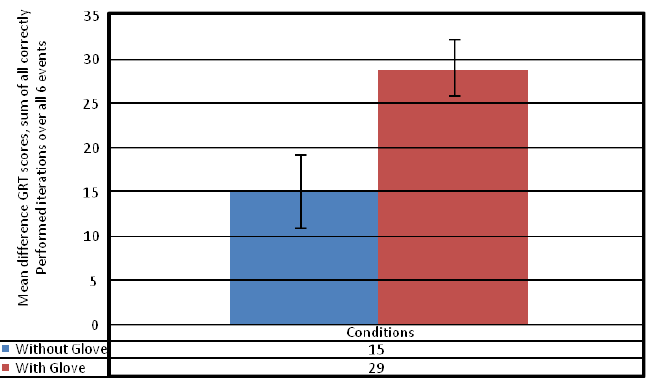
Fig. 13. Graphical depiction of Grasp and Release Test results by